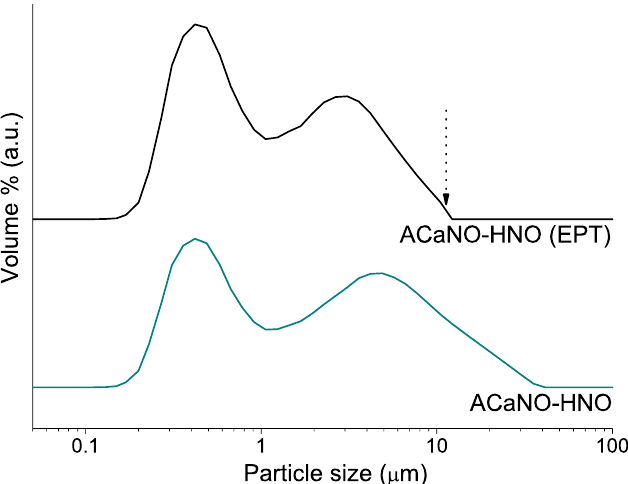
Figure 4. Particle size distributions of the sol – gel synthesized powders: without post-synthesis treatment (ACaNO-HNO), and after EPT (ACaNO-HNO (EPT)).